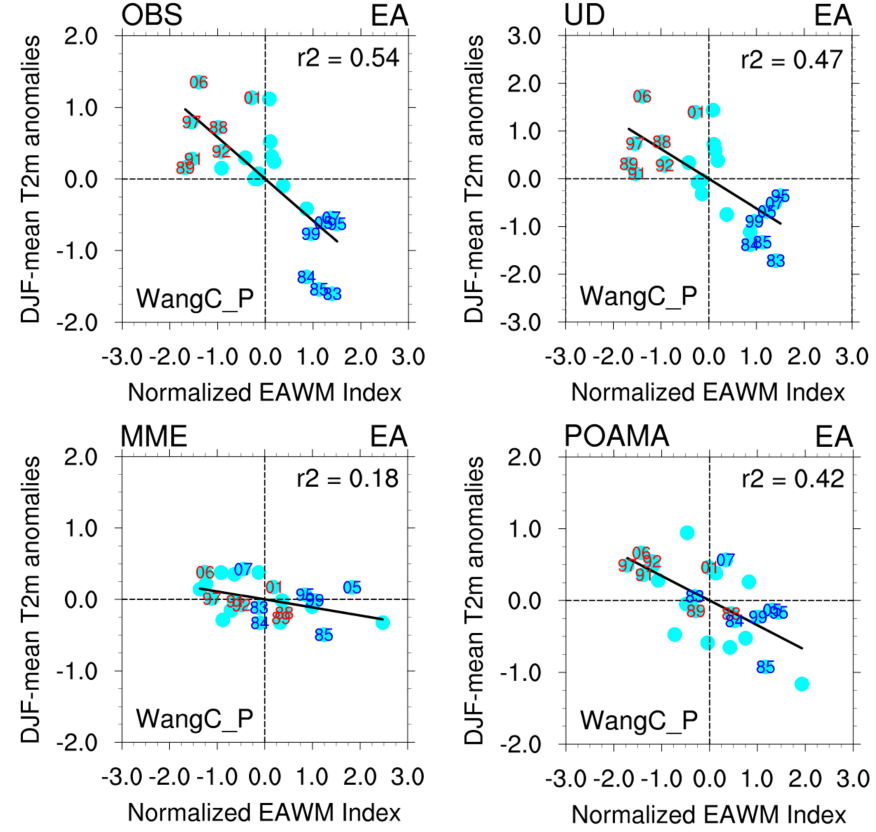
Figure 12. Scatter plots of normalized EAWM index vs. DJF-mean temperature anomalies averaged over East Asia (100–145 ◦ E, 20–50 ◦ N) for the period 1983–2007 based on the EAWM index defined by Wang and Chen